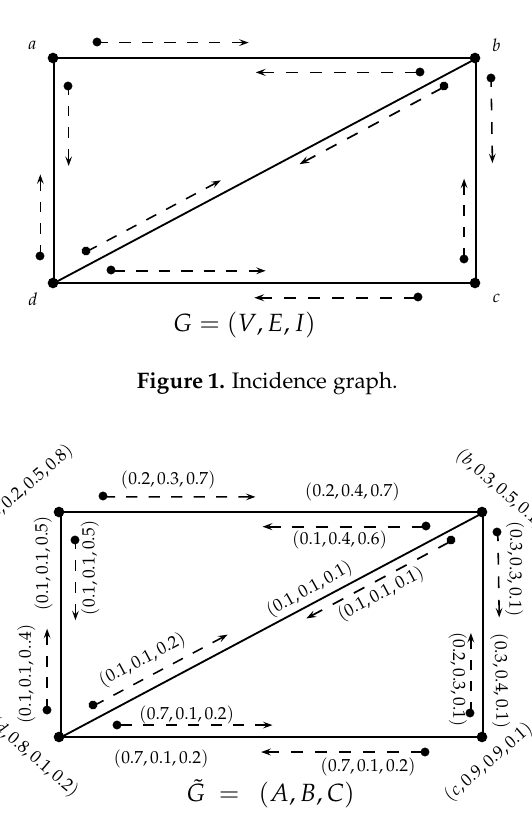
Figure 2. Single-valued neutrosophic incidence